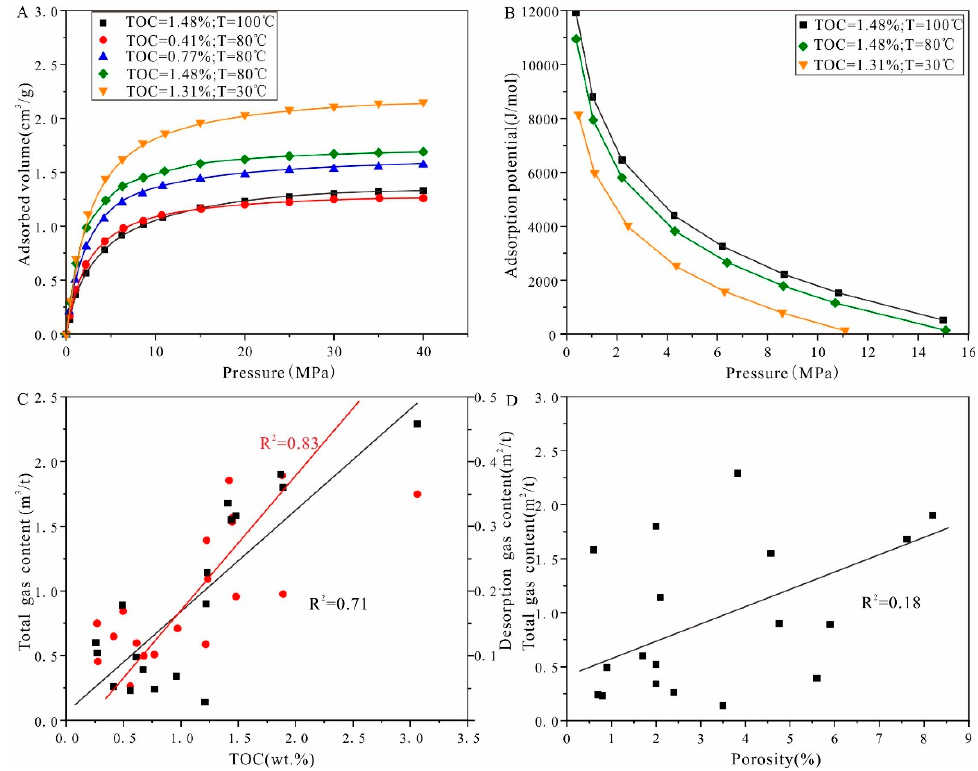
Figure 11. The gas potential of the Da’anzhai member shale. ( A ) and ( B ) isothermal adsorption curves and adsorption potential at different temperatures; ( C ) and ( D ) relationship between TOC, porosity and total gas content.